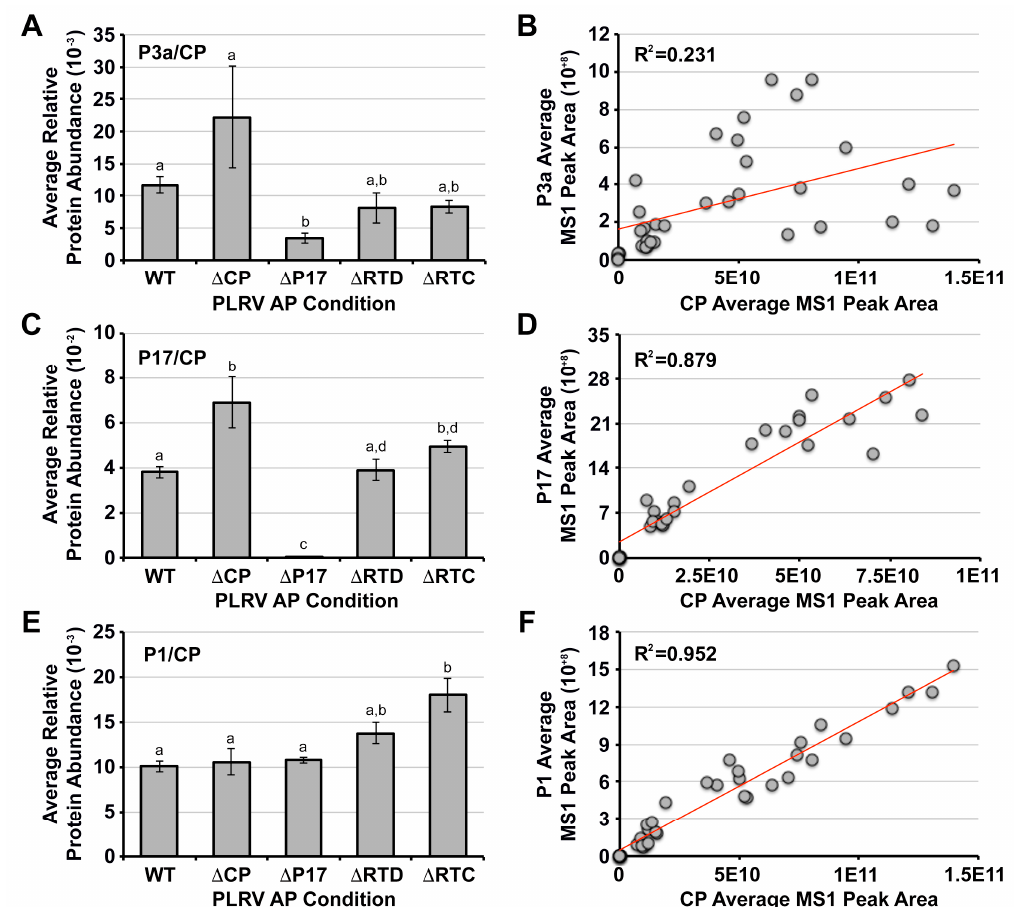
Figure 2. Comparative analysis of WT and mutant PLRV affinity purifications (AP) shows partial loss of P3a when P17 is absent. ( A , C , E ) Bar graphs show the average, relative protein abundance measured by MS1 peak area integration (unit-less) of ( A ) P3a, ( C ) P17 movement protein, and ( E ) P1 polyprotein in AP samples for each of the PLRV infection conditions normalized to the levels of the PLRV coat protein domain (CP) in those same samples. Error bars represent the ± standard error. Lowercase letters represent a significant difference ( p < 0.05) measured by a Kruskal-Wallis rank sum test followed by a Conover post-hoc pairwise multiple comparison, which was further adjusted by the Holm FWER method; ( B , D , F ) Linear regression analysis between the average, relative levels of CP, and ( B ) P3a, ( D ) P17, and ( F ) P1 measured by MS1 peak area integration in each of the analytical AP replicates per PLRV infection condition. The coefficient of determination (R 2 ) is given for each regression line (red). Values for P17 and CP in the ∆ P17 null-mutant APs were not included in panel ( D ) since P17 was not detected above background noise in these samples (see panel C). The number of peptides used for MS1 peak area integration are: CP = 10, P3a = 2, P17 = 2, and P1 = 4 (Supplemental Table